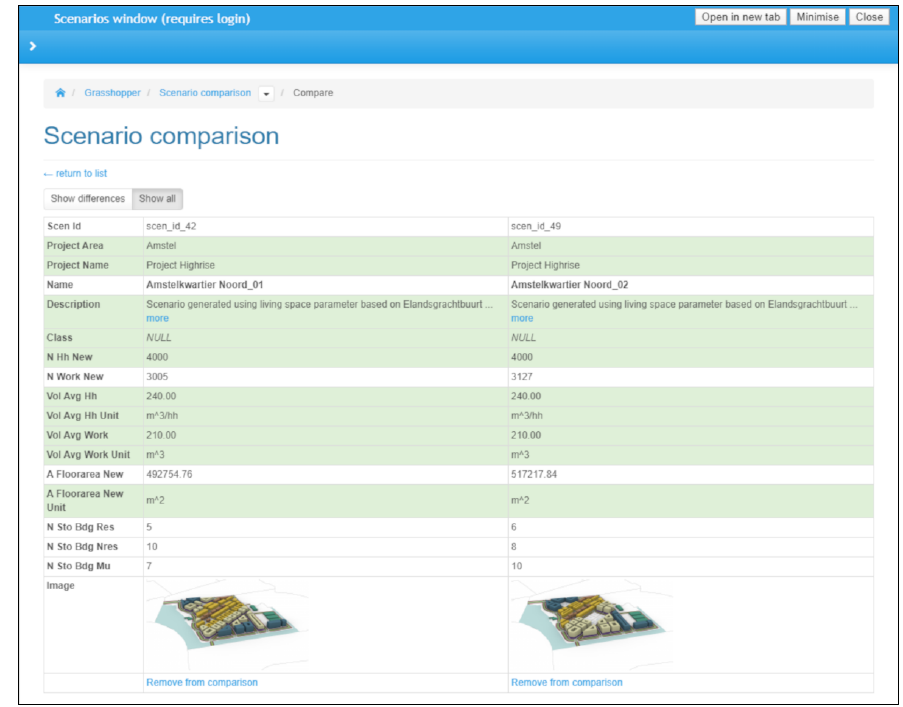
Figure 10. Examples of the online data exploration via the Scenario comparison page.